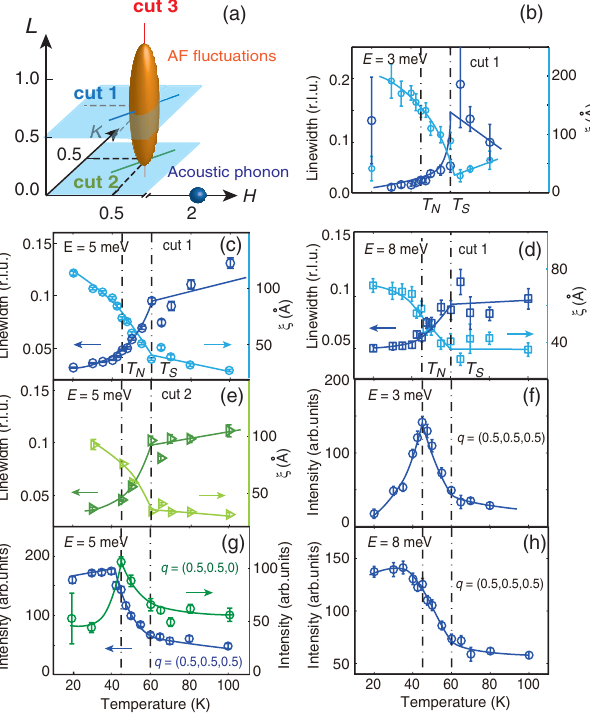
FIG. 3. (a) Sketch of the reciprocal space in which AF spin fluctuations and acoustic phonons are marked as a yellow ellipsoid and a blue sphere. The directions along which we measured in the experiment are shown as blue, green, and red lines. (b) – (e) Temperature-dependent linewidths and correlation lengths of the low-energy spin fluctuations. They are measured along the cut-1 direction at (b) 3 meV, (c) 5 meV, and (d) 8 meV, and (e) along the cut-2 direction at 5 meV. (f) – (h) Temperature dependence of the peak intensity in each scan. It is clear that there are negative correlations between the peak intensity and the peak width before the system enters into the AF ordered state, representing a redistribution of spectral weight in the nematic phase below T s . The vertical dashed lines mark the magnetic and structural transition temperatures.